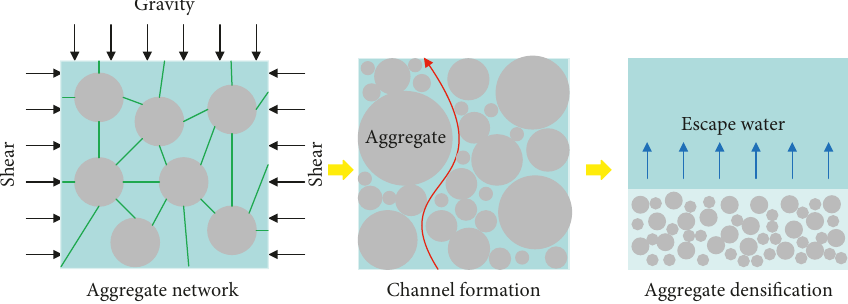
Figure 5: Scheme of aggregate densification and channel